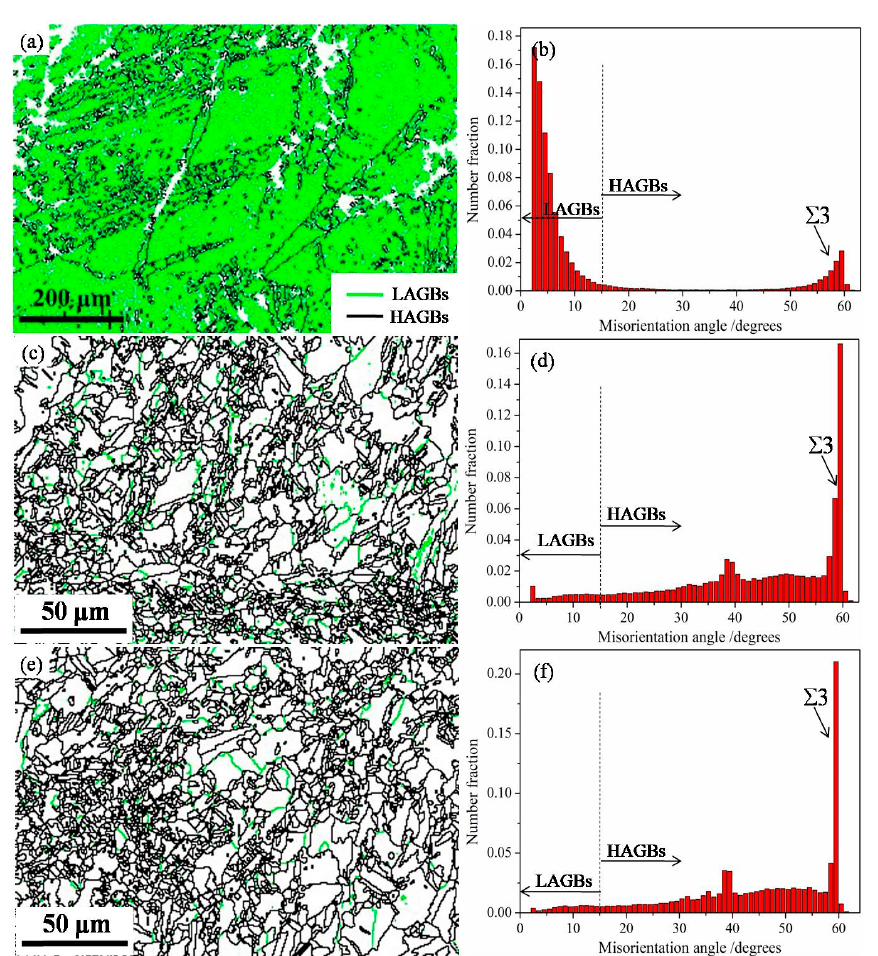
Figure 5. Evolution of grain boundary for different samples: ( a , c , e ) grain boundary map; ( b , d , f ) the corresponding misorientation angle; ( a , b ) deformed sample; ( c , d ) annealed sample at 900 °C for 15 min; and ( e , f ) annealed sample at 900 °C for 120 min.